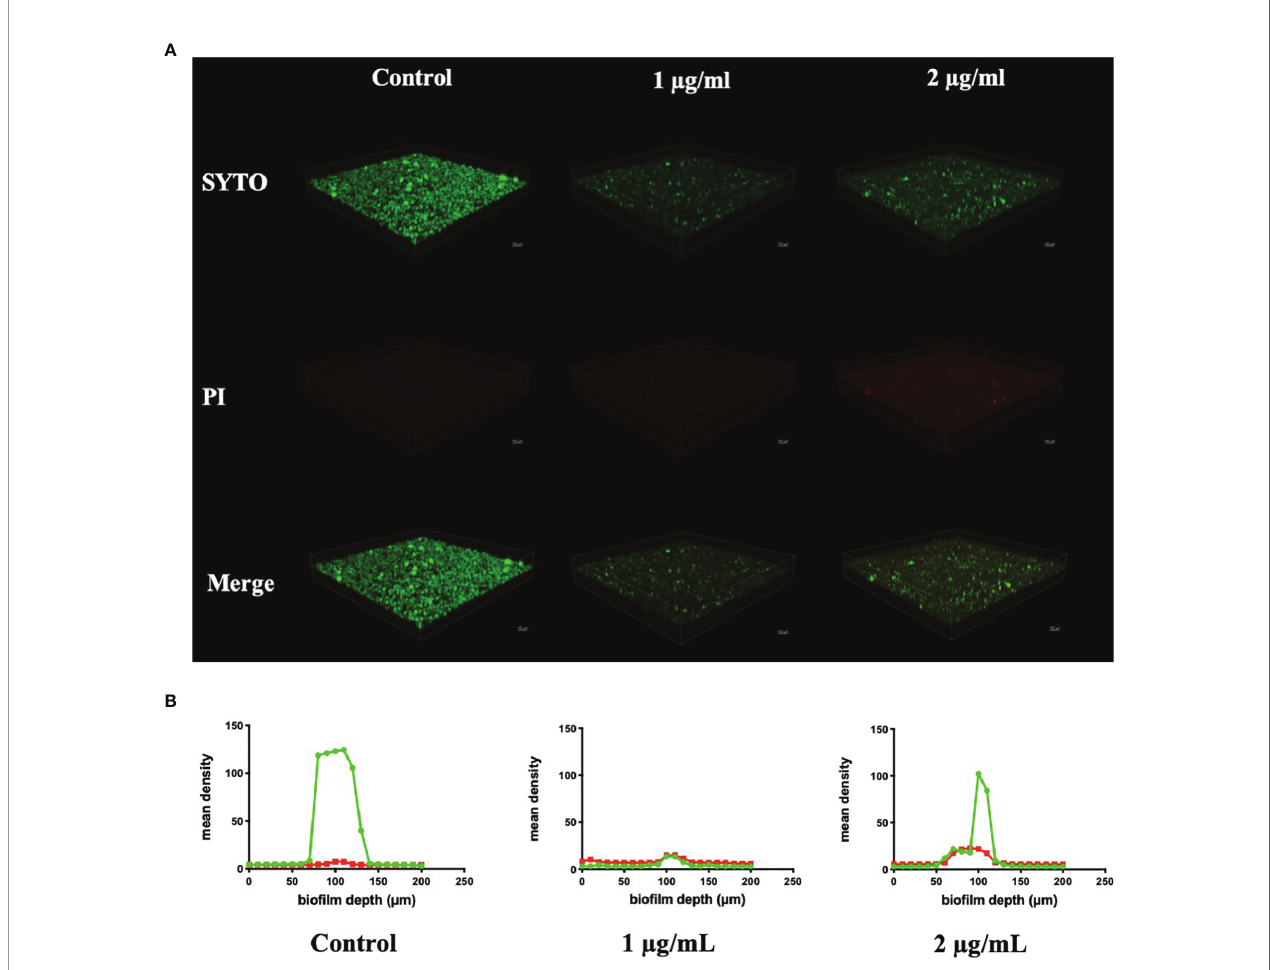
FIGURE 4 | Live/dead staining of Streptococcus mutans UA159 bio fi lms treated with 1 and 2 µg/ml of 1,3-bis[3,5-bis(tri fl uoromethyl)phenyl]urea (BPU). (A) Representative three-dimensional visualization of live (green) and dead (red) cells in S. mutans bio fi lms formed on saliva-coated hydroxyapatite (sHA) discs. (B) Mean density of green and red fl uorescence throughout S. mutans bio fi lms quanti fi ed using ImageJ software.